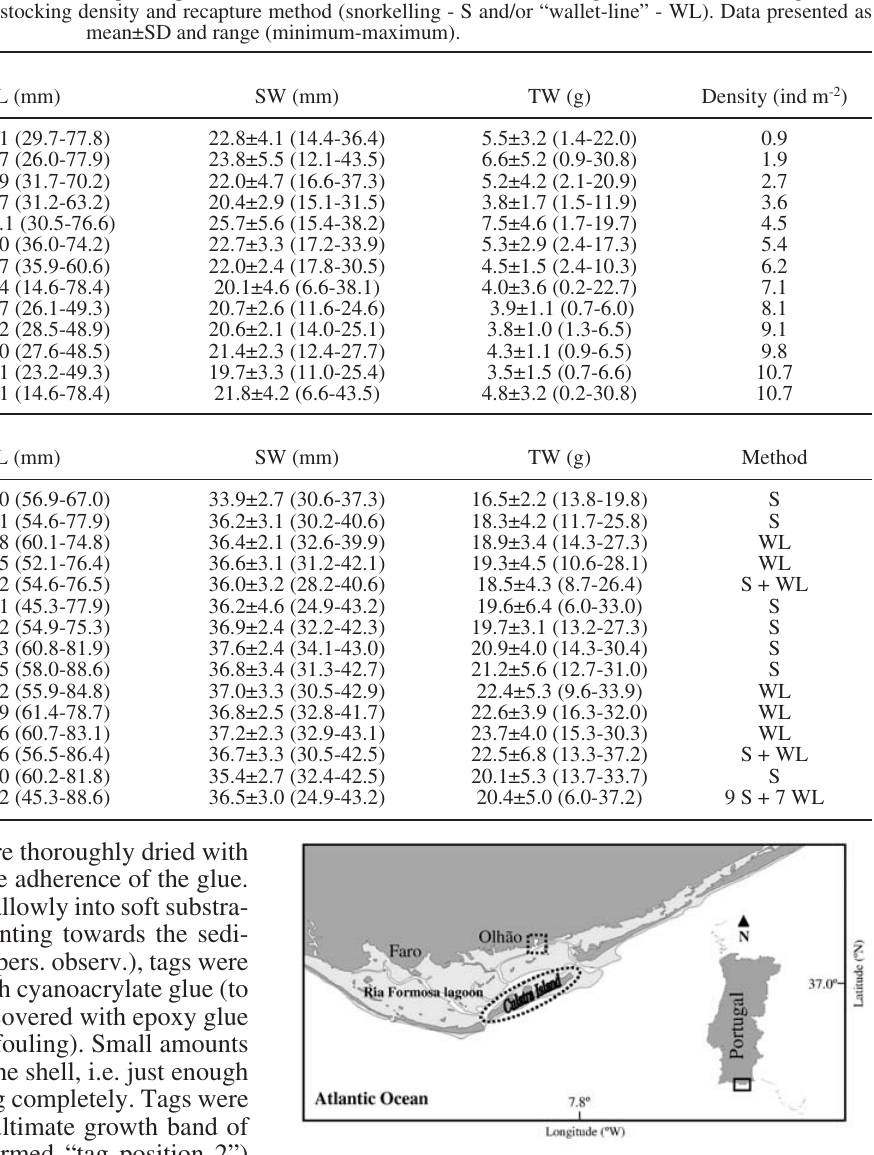
Fig. 1. − Map of the Ria Formosa lagoon (Algarve coast - southern Portugal), showing Culatra Island (dotted ellipse) where Bolinus brandaris was caught, and IPIMAR’s Fish Culture Experimental Station in Olhão (dotted square) where the mark-recapture experi- ments were